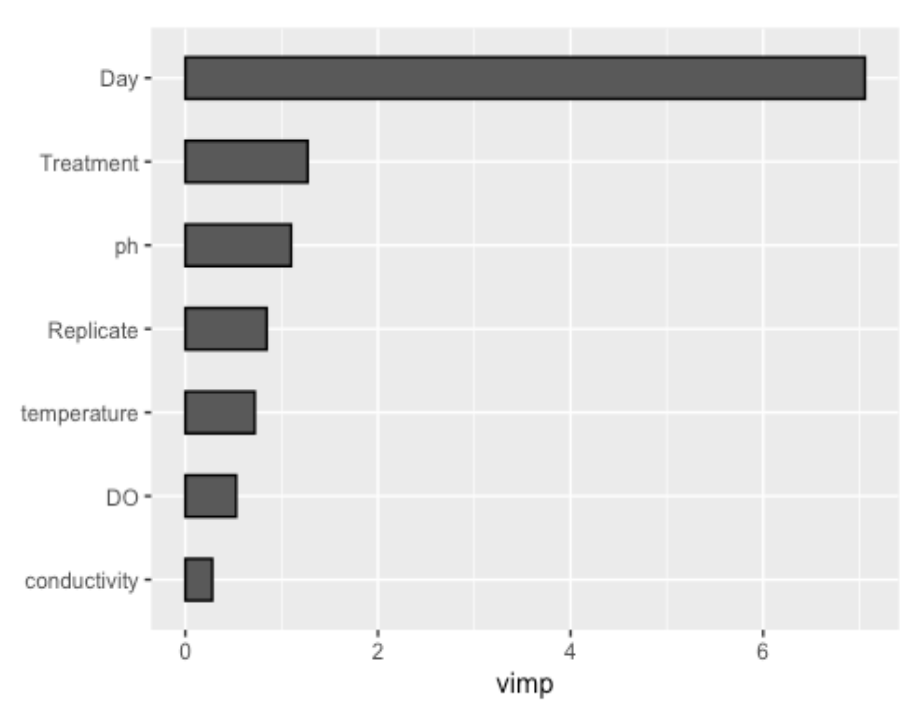
Figure A1. Variable importance explaining changes in mortality according to Random Forests.